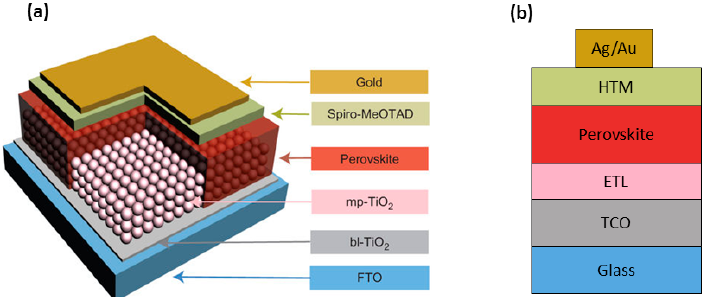
Figure 2. Schematic illustration of the ( a ) mesoscopic and ( b ) planar perovskite solar-cell configurations. In the mesoscopic architecture (a), a smooth perovskite capping layer covers the top of the mesoporous TiO 2 layer. The hole-transporting material (HTM), typically 2,2’,7,7’-tetrakis-( N , N’ -di- p - methoxyphenylamine)-9,9’-spirobifluorene) (spiro-OMeTAD), is spin-coated atop the perovskite film. The most frequent film thicknesses reported for the layers of perovskite solar cell (PSC) structures are 50 nm (blocking TiO 2 layer, bl-TiO 2 ), 300 nm (mesoporous TiO 2 , mp-TiO 2 ), 4–500 nm (perovskite), 1–200 nm (spiro-OMeTAD capping layer) and 80 nm (gold/silver). Please note that a systematic layer thickness optimization is still missing in the literature. In the planar configuration (b), the perovskite film is deposited directly on top of the electron-transporting layer (ETL), commonly a TiO 2 dense hole-blocking layer (the original figure in (a) was reproduced with permission from [24], published by Nature Publishing Group). FTO, fluorine-doped tin oxide; TCO, transparent conducting oxide.